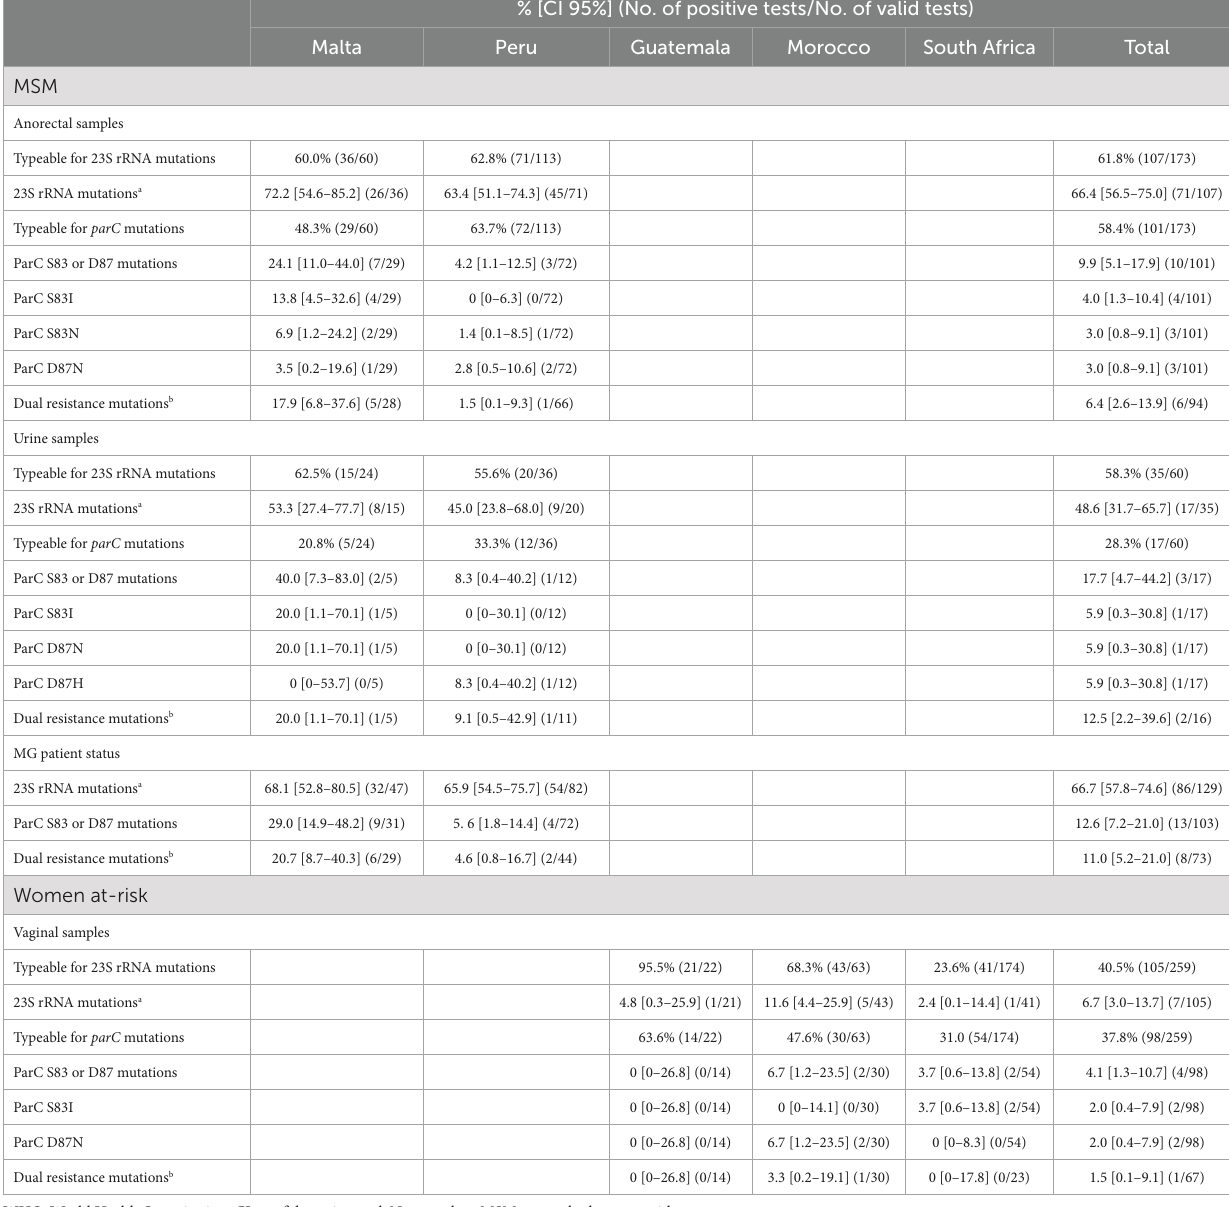
TABLE 2 Prevalence of M. genitalium macrolide and quinolone resistance-associated mutations in high-risk populations in five countries in four WHO